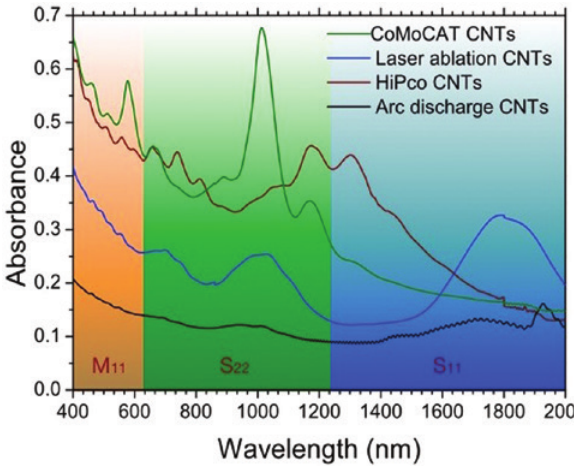
Figure 5: Small signal absorption spectrum of CNTs, produced by arc discharge, laser ablation, HiPco and CoMoCAT